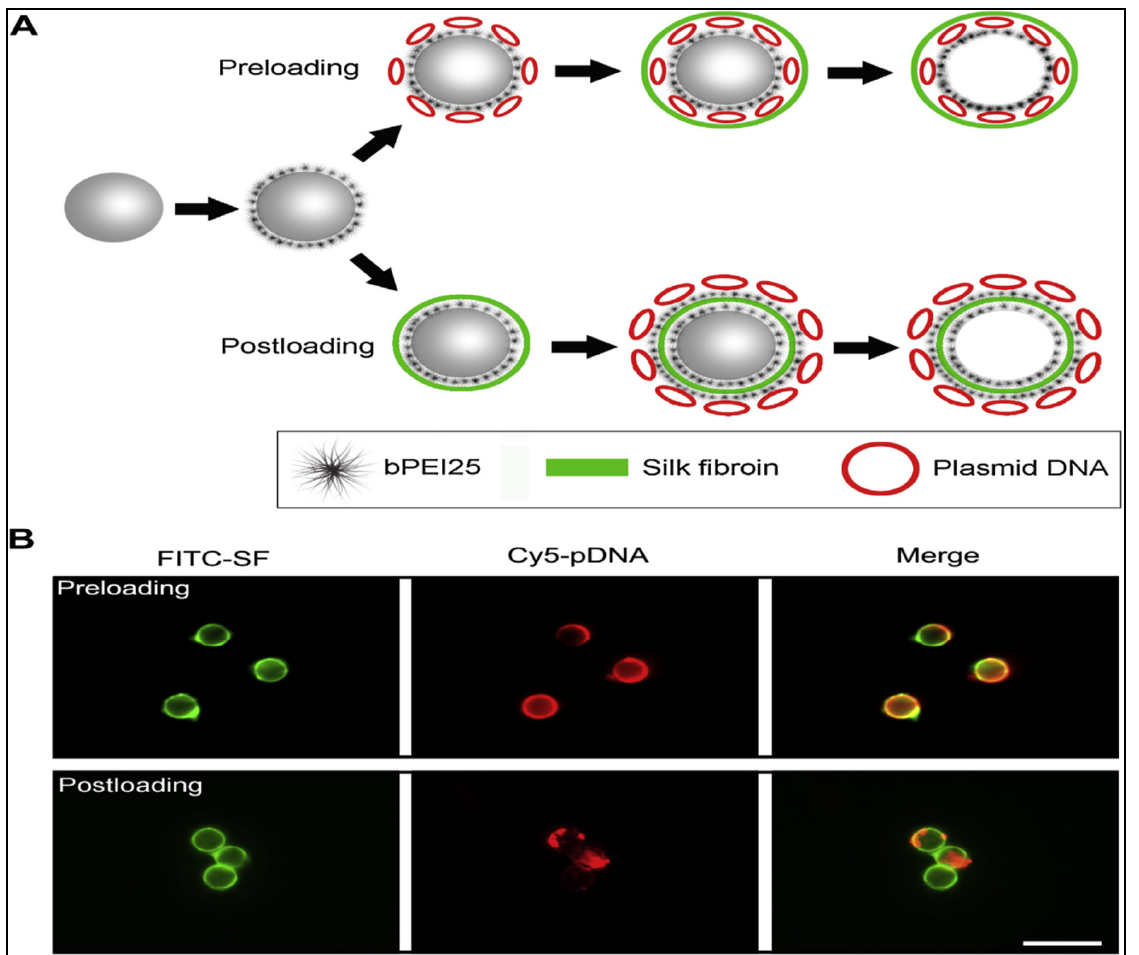
Figure 3. SF microcapsules of plasmid DNA are packaged. ( A ) A diagram depicting the initialization of pDNA before and after it has been loaded. Preloading: pDNA was adsorbed onto bPEI25 functionalized PS particles; SF was mounted on the pDNA-coated particles using LbL; the SF was stabilised, and the core was removed. PS particles were coated with bPEI25 after loading; SF was assembled LbL onto bPEI25-coated PS particles; the center was removed after pDNA was adsorbed onto the bPEI25eSF casing after another bPEI25 coating. ( B ) Photos obtained with a fluorescence microscope of 4 mm SF microcapsules that had been pre- or post-loaded with pDNA. FITC ( green ) was used to mark SF, and Cy5 was used to label pDNA ( red ). 10 mm scale bar. Reprinted with permission from reference